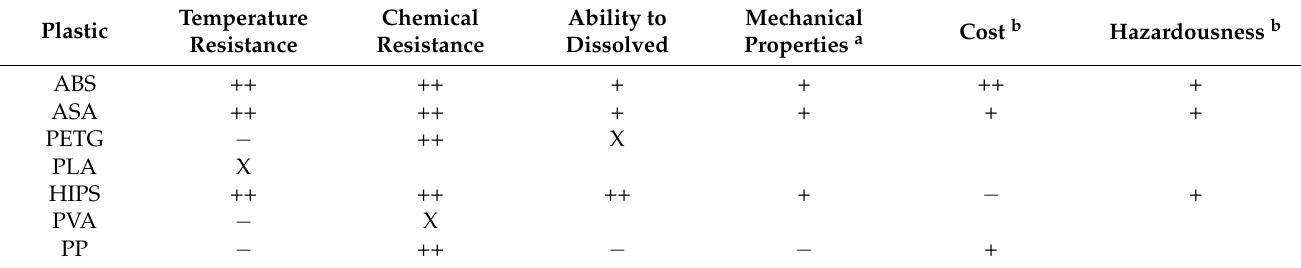
Table 5. Summary of advantages and disadvantages of possible plastics for 3D printing selection. Subjectively judged using the following scale: ++/+/ − /X, where ++ is ideal, + is good, − is a minor drawback, and X is grounds for rejection. Empty cells correspond to plastics that were rejected before judging the corresponding